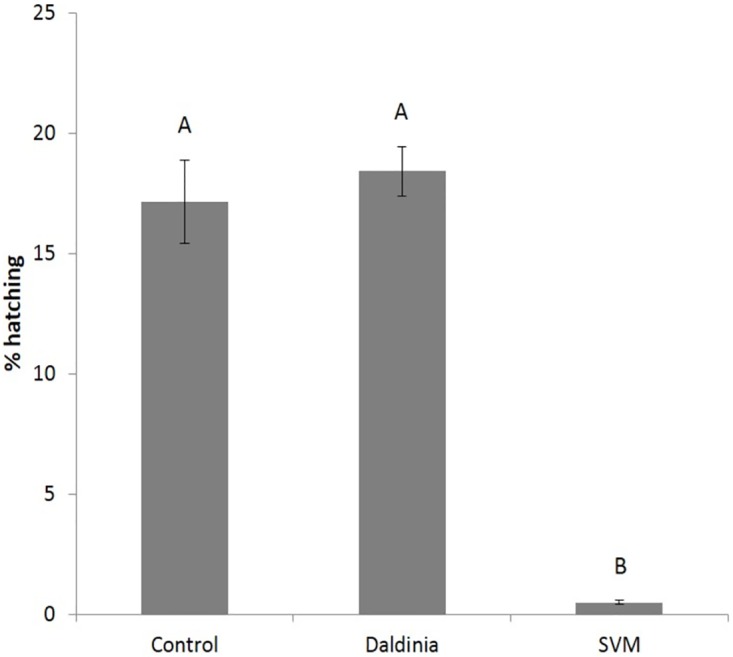
Effects of D. cf. concentrica volatiles and of the SVM on M. javanica eggs.The eggs were exposed for 48 h either to D. cf. concentrica grown in three 50-mm-diameter culture plates, each loaded with 5 mL of growth medium or to 0.25 mL/L (V/V) of the SVM [3-methyl-1-butanol (0.05 mL, 0.46 mmole), (±)-2-methyl-1-butanol (0.05 mL, 0.46 mmole), 4-heptanone (0.1 mL, 0.72 mmole), and isoamyl acetate (0.05 mL, 0.34 mmole)] preloaded onto 125 mg of perlite particles. Each treatment used 10 repetitions each using 800 eggs. The numbers on the y-axis represent the means (± SE) of percentage of egg hatching. The results were subjected to analysis of variance followed by the Tukey-Kramer multiple comparison test; different letters above the bars indicate a significant difference between samples at P ≤ 0.05. The experiment was independently repeated three times, each time with similar results.